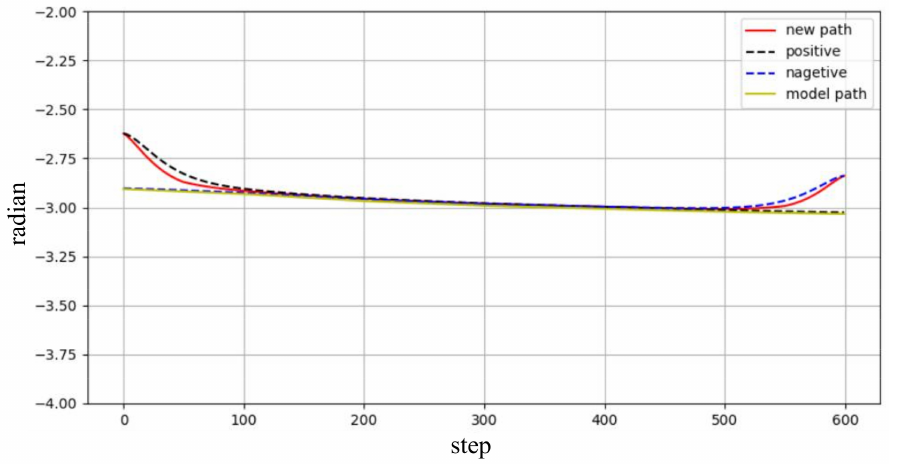
Figure 14. Effect after path